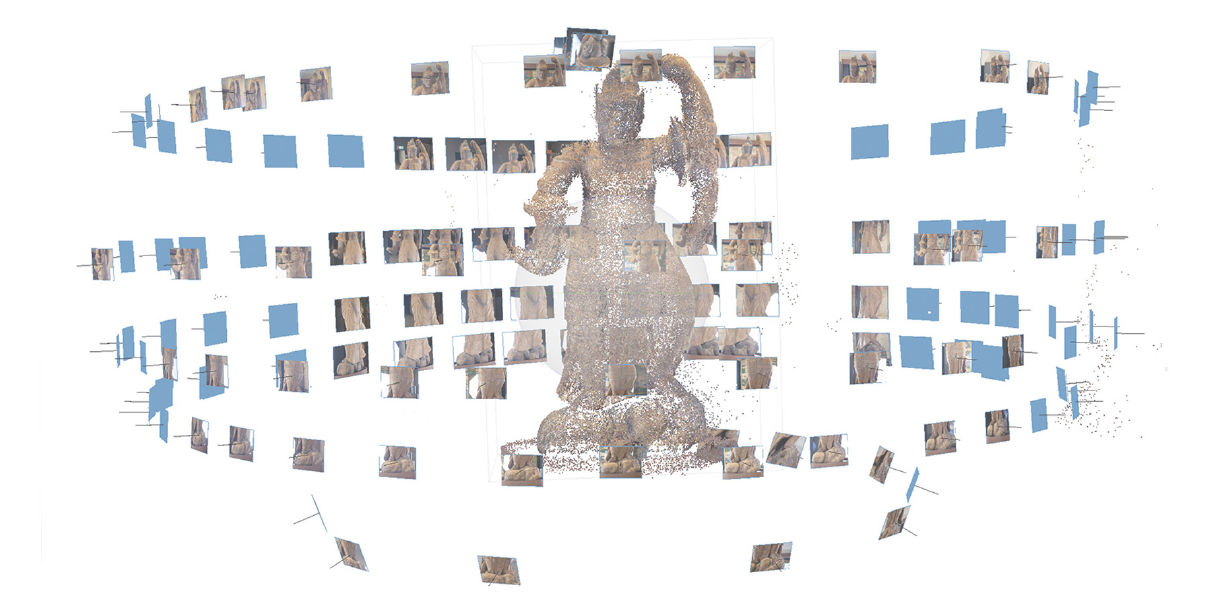
Figure 2 . Photo alignment with sparse cloud. Processing: F. Ronco, S.